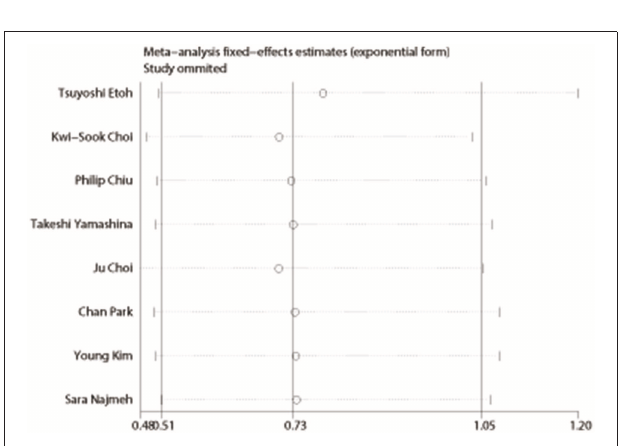
FIGURE 9 | Sensitivity analysis of overall survival.